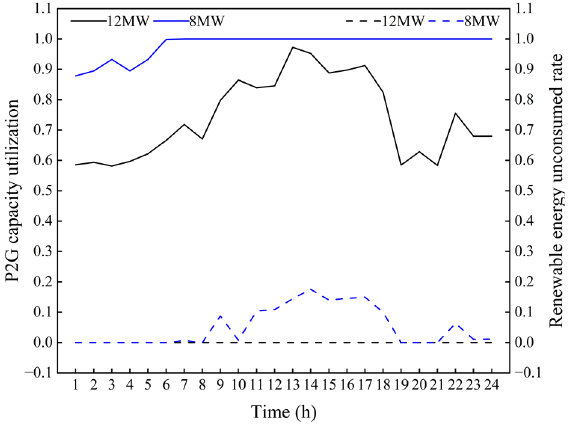
Figure 10. P2G utilization and dissipation in PIES 1 for scenario 2.